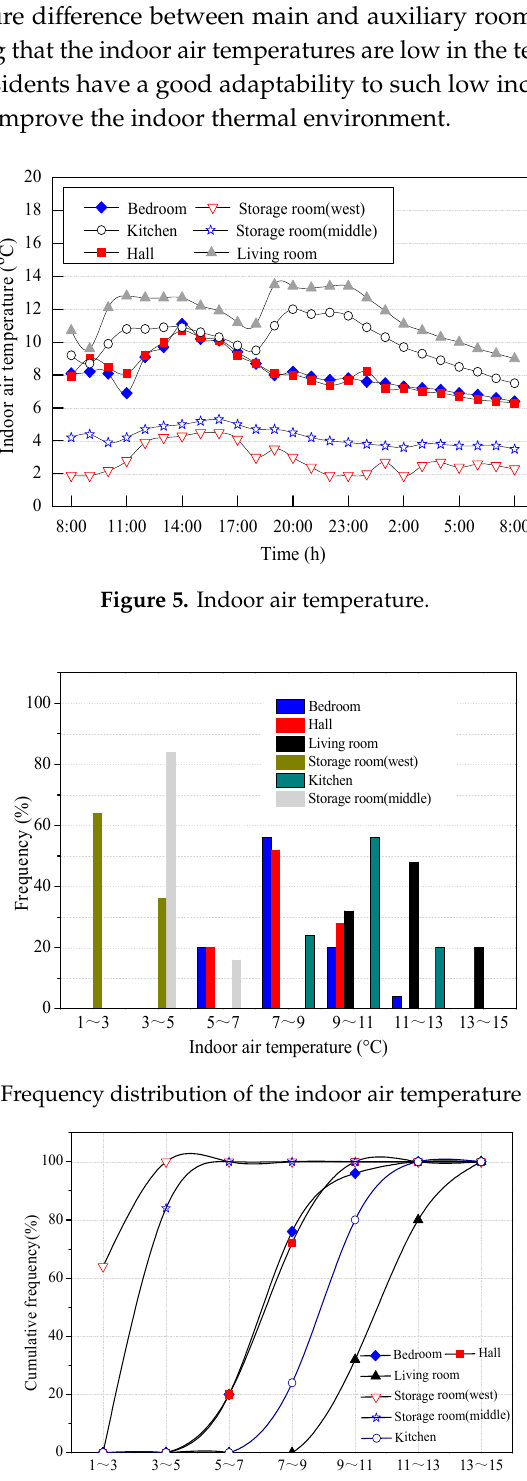
Figure 7. Cumulative frequency distribution of the indoor air temperature segments.